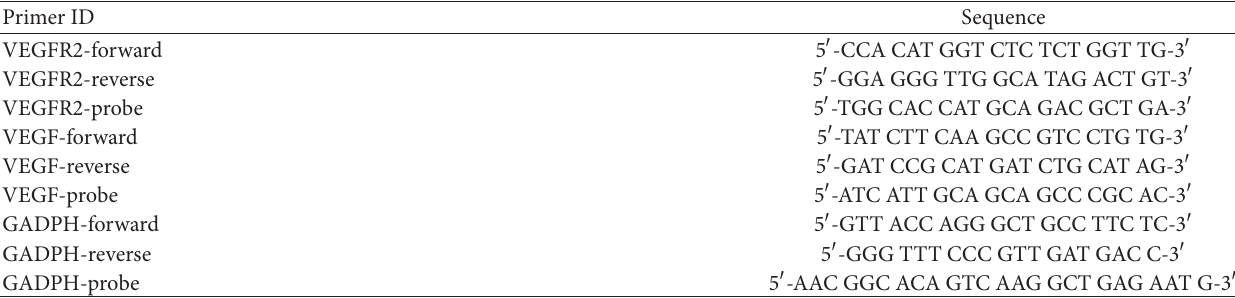
Table 1: Primers and probes which were used in real-time PCR.